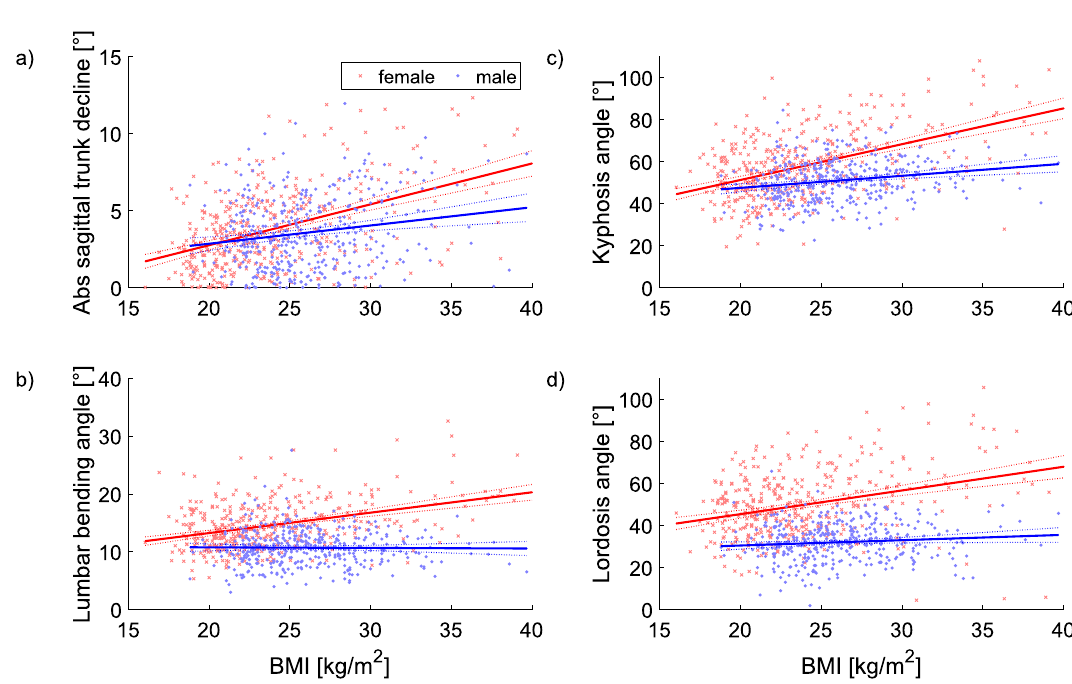
Figure 3. The BMI-dependent relationships of selected variables. Legend Abs, Absolute